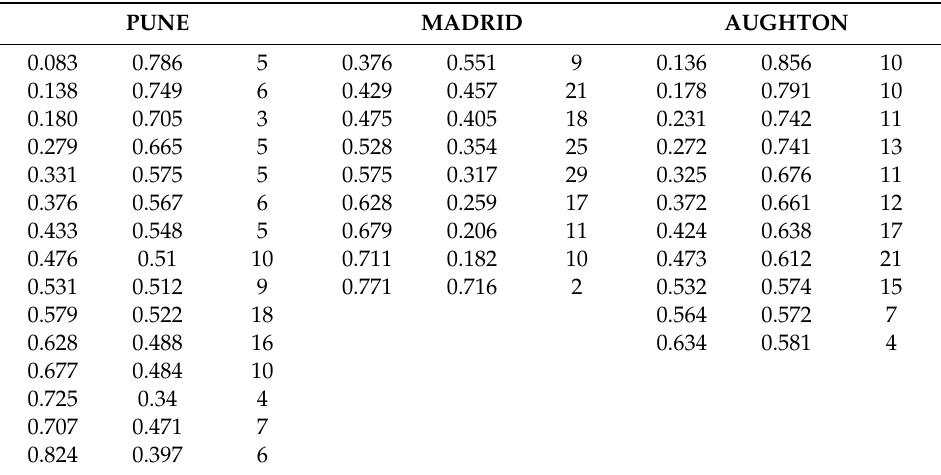
Table 5. Averaged k Values for Each Increment at Bandwidth of k t of 0.05 Widths.